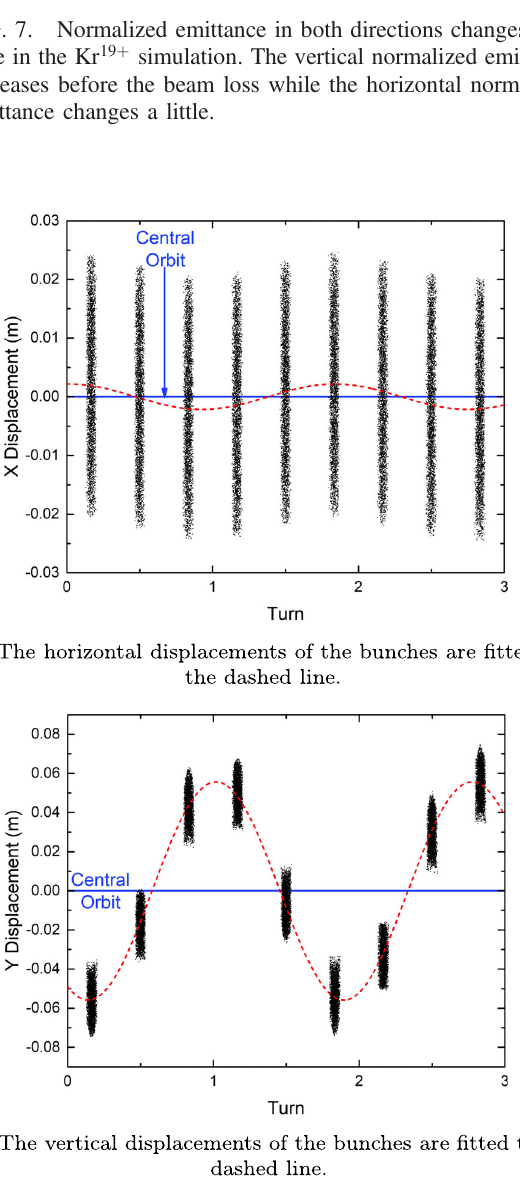
FIG. 8. Bunches oscillate around the central orbit and their displacements can be fitted by a sine